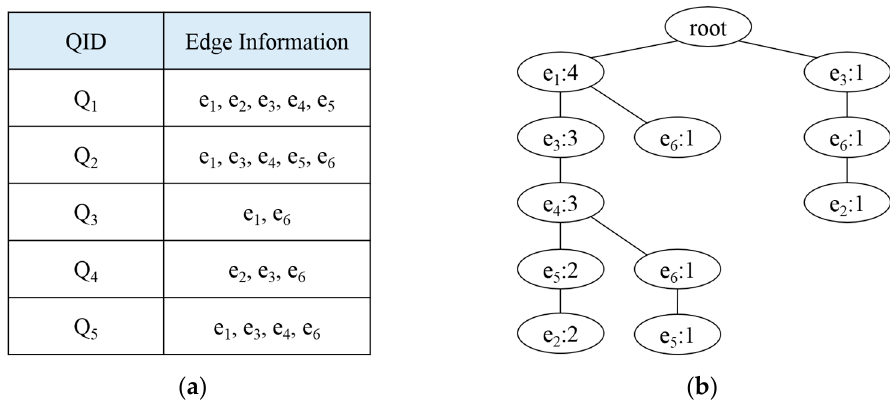
Figure 3. Query history and FP-tree: ( a ) query history management table; ( b ) FP-tree.